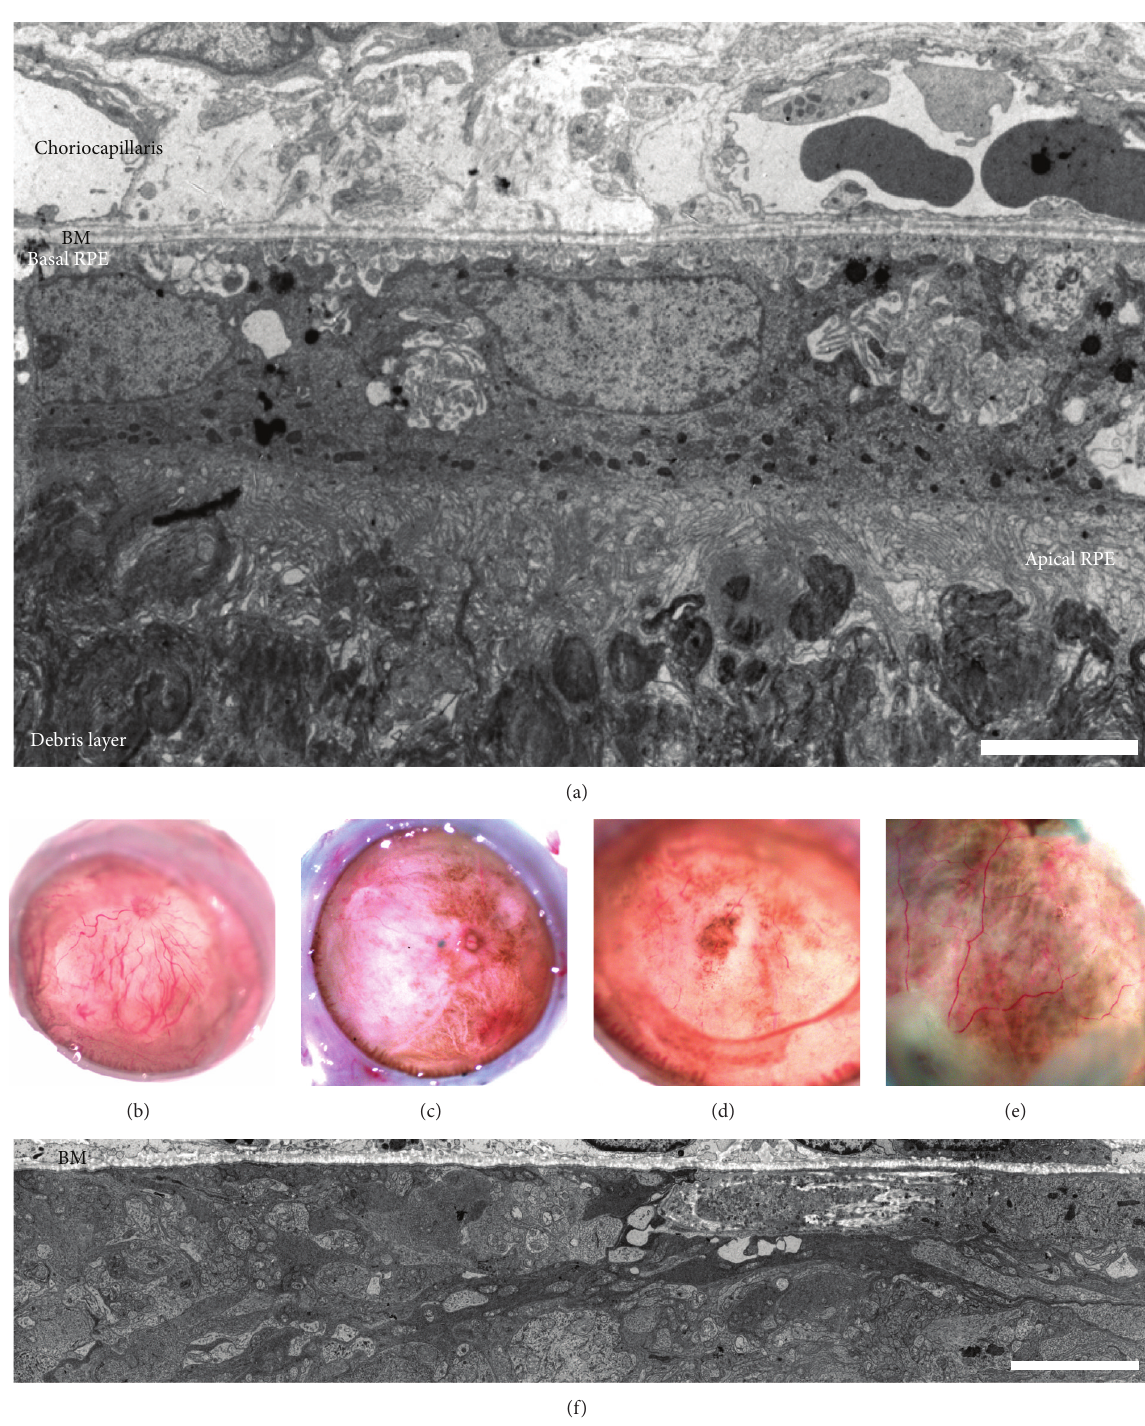
Figure 1: Melanin-laden cells are enriched in RPE compartments of aging RCS rat retinas. (a) Ultrastructural examinations from a RCS rat four weeks after implantation with iPS-RPE. Note RPE polarization between the choriocapillaris, Bruch’s membrane (BM), and the debris layer. (b–e) A panel of 2+-year-old uninjected (b) and iPSC-RPE injected (c–e) eyes with corneas and lenses removed. Note the broad distributions of pigmented zones. (f) Electron micrograph of the subretinal space of a 17-month-old uninjected RCS rat. Scale bars = 5 𝜇